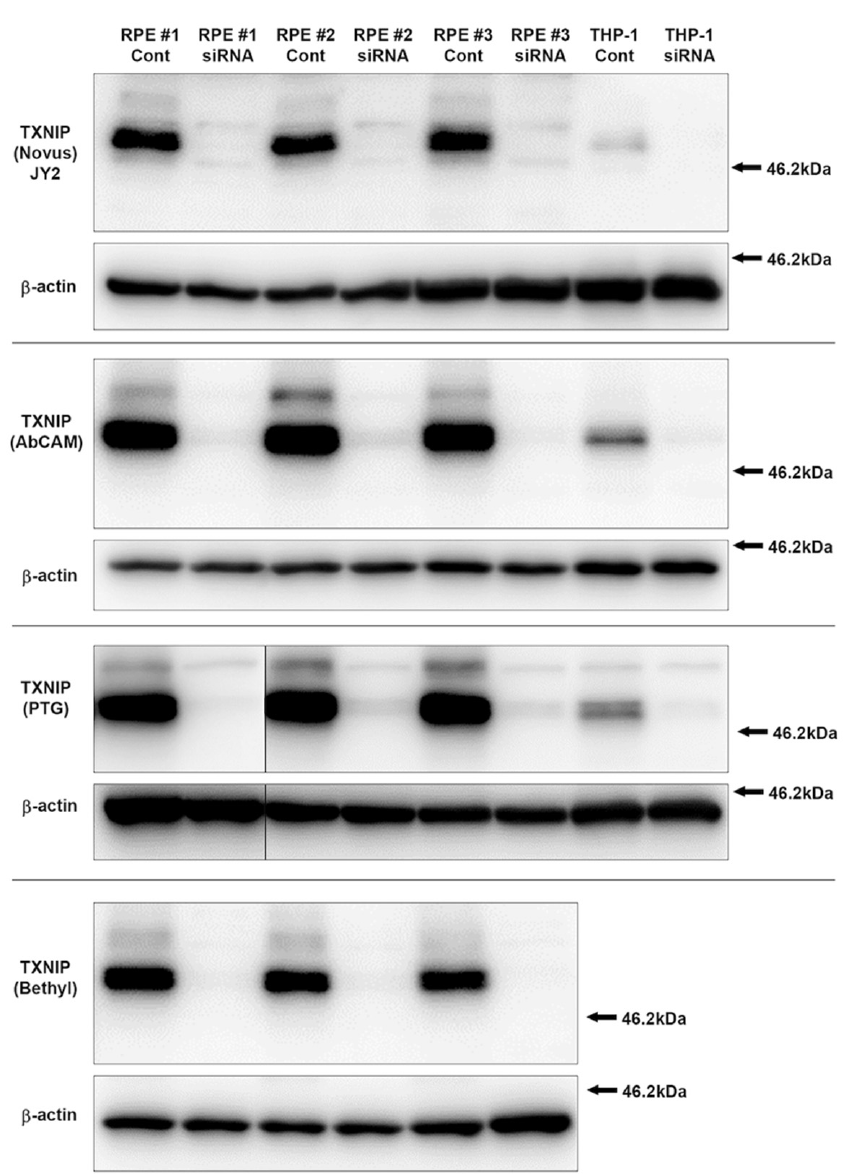
Figure 1. Validation of TXNIP antibodies from different sources using TXNIP specific siRNA knockdown of protein in ARPE-19 retinal pigment epithelial (RPE) and THP-1 macrophages. Composite immunoblots showing matched results using the indicated antibodies. Results demonstrate significant knockdown of bands of 50–55 kDa of the expected molecular weight of TXNIP for all antibodies. Abbreviations: RPE, extracts of ARPE-19 retinal pigment epithelial cells; THP-1, extract of THP-1-derived macrophages; Cont, cell extracts from cells transfected with non-specific control siRNA sequence; siRNA, cell extracts from cells transfected with TXNIP-specific siRNA sequences; kDa, kilodaltons.